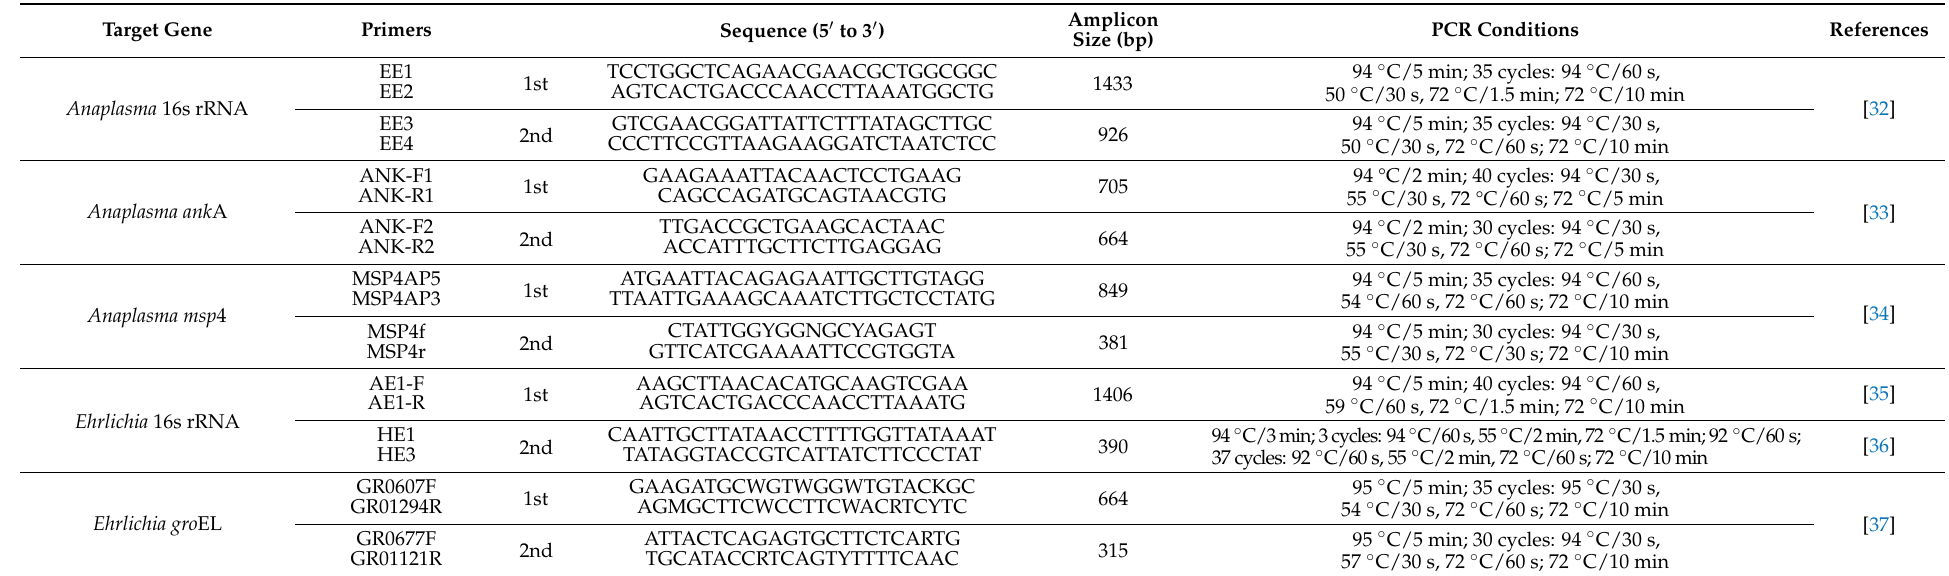
Table 1. Primers used for the detection of Anaplasma and Ehrlichia in